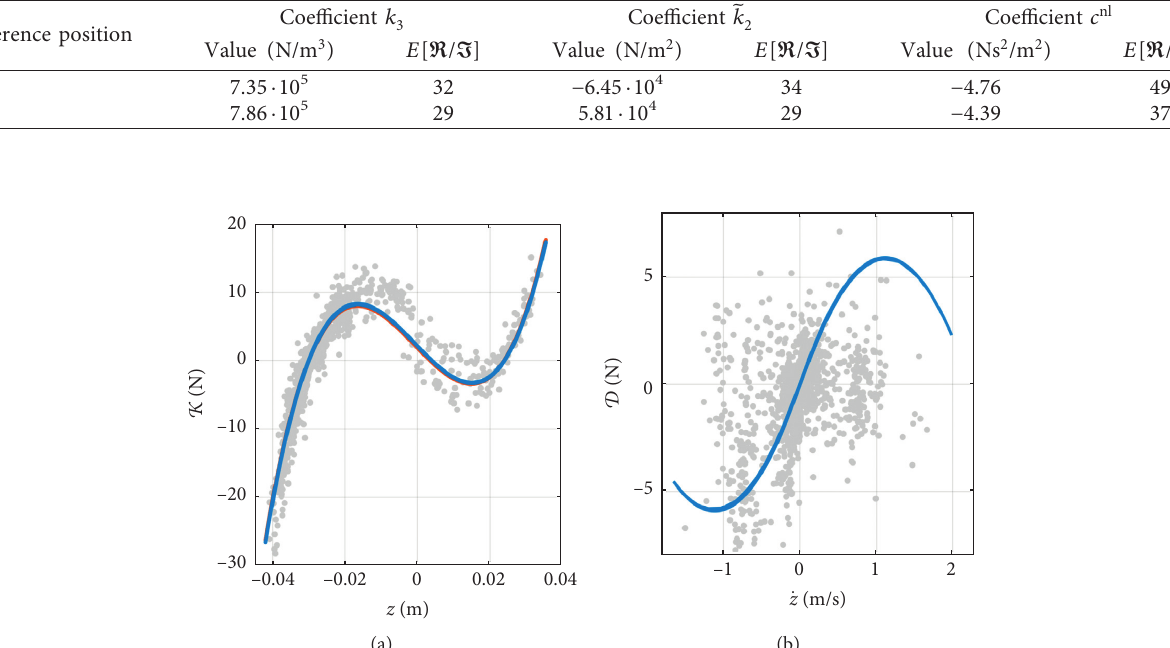
Table 2: Identified coefficients with NSI for the two reference positions.